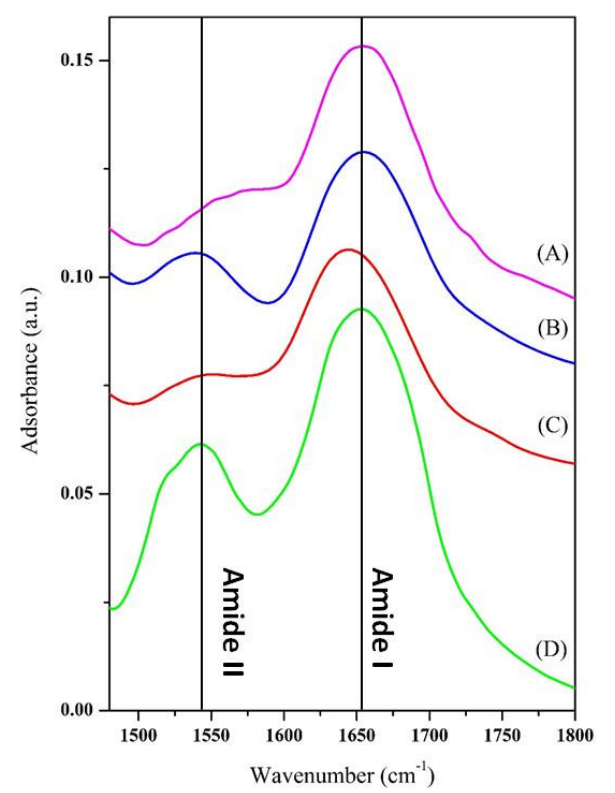
Figure 7. FT-IR spectra of cellulase adsorbed in WSN-p at 30 (A), 40 (B) and 50 °C (C), and of free cellulase (D).